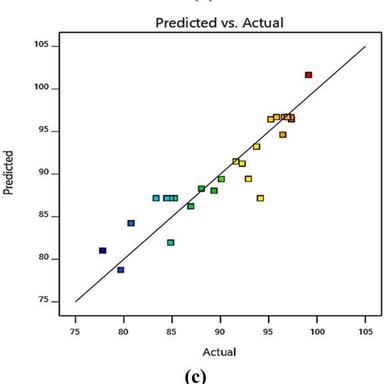
Plots of (a) 3D surface in dark condition; (b) 3D surface in light irradiation; (c) predicted vs. actual values for flux response.